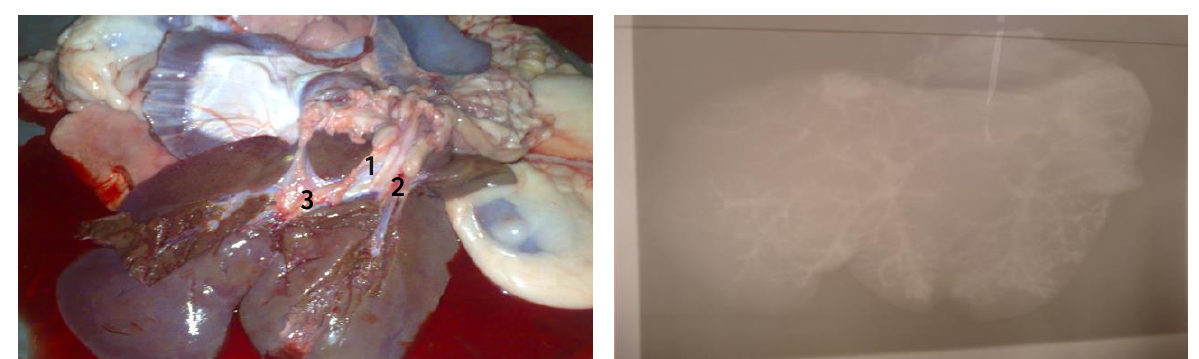
Figure, 2: papillary1; caudate; left intrahepatic branch of portal vein